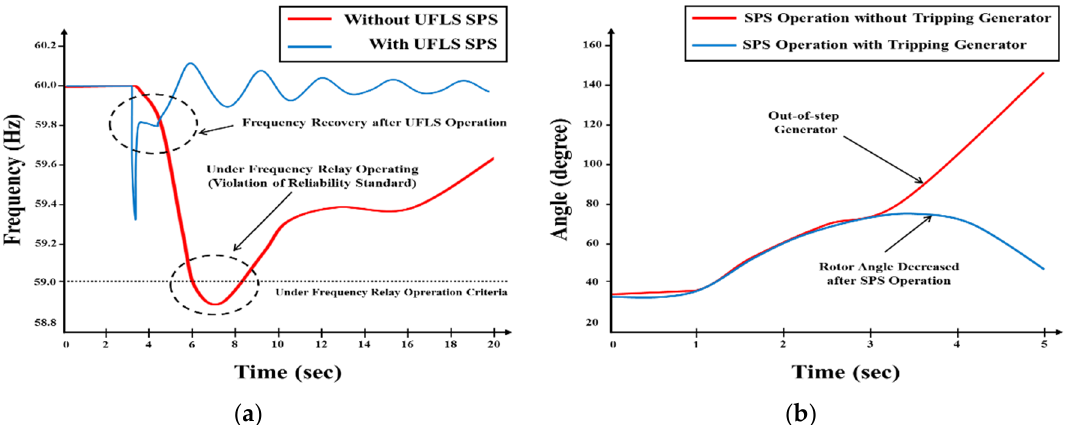
Figure 20. Frequency and angle responses for the cases with and without special protection scheme based on proposed method; ( a ) frequency, ( b ) angle.